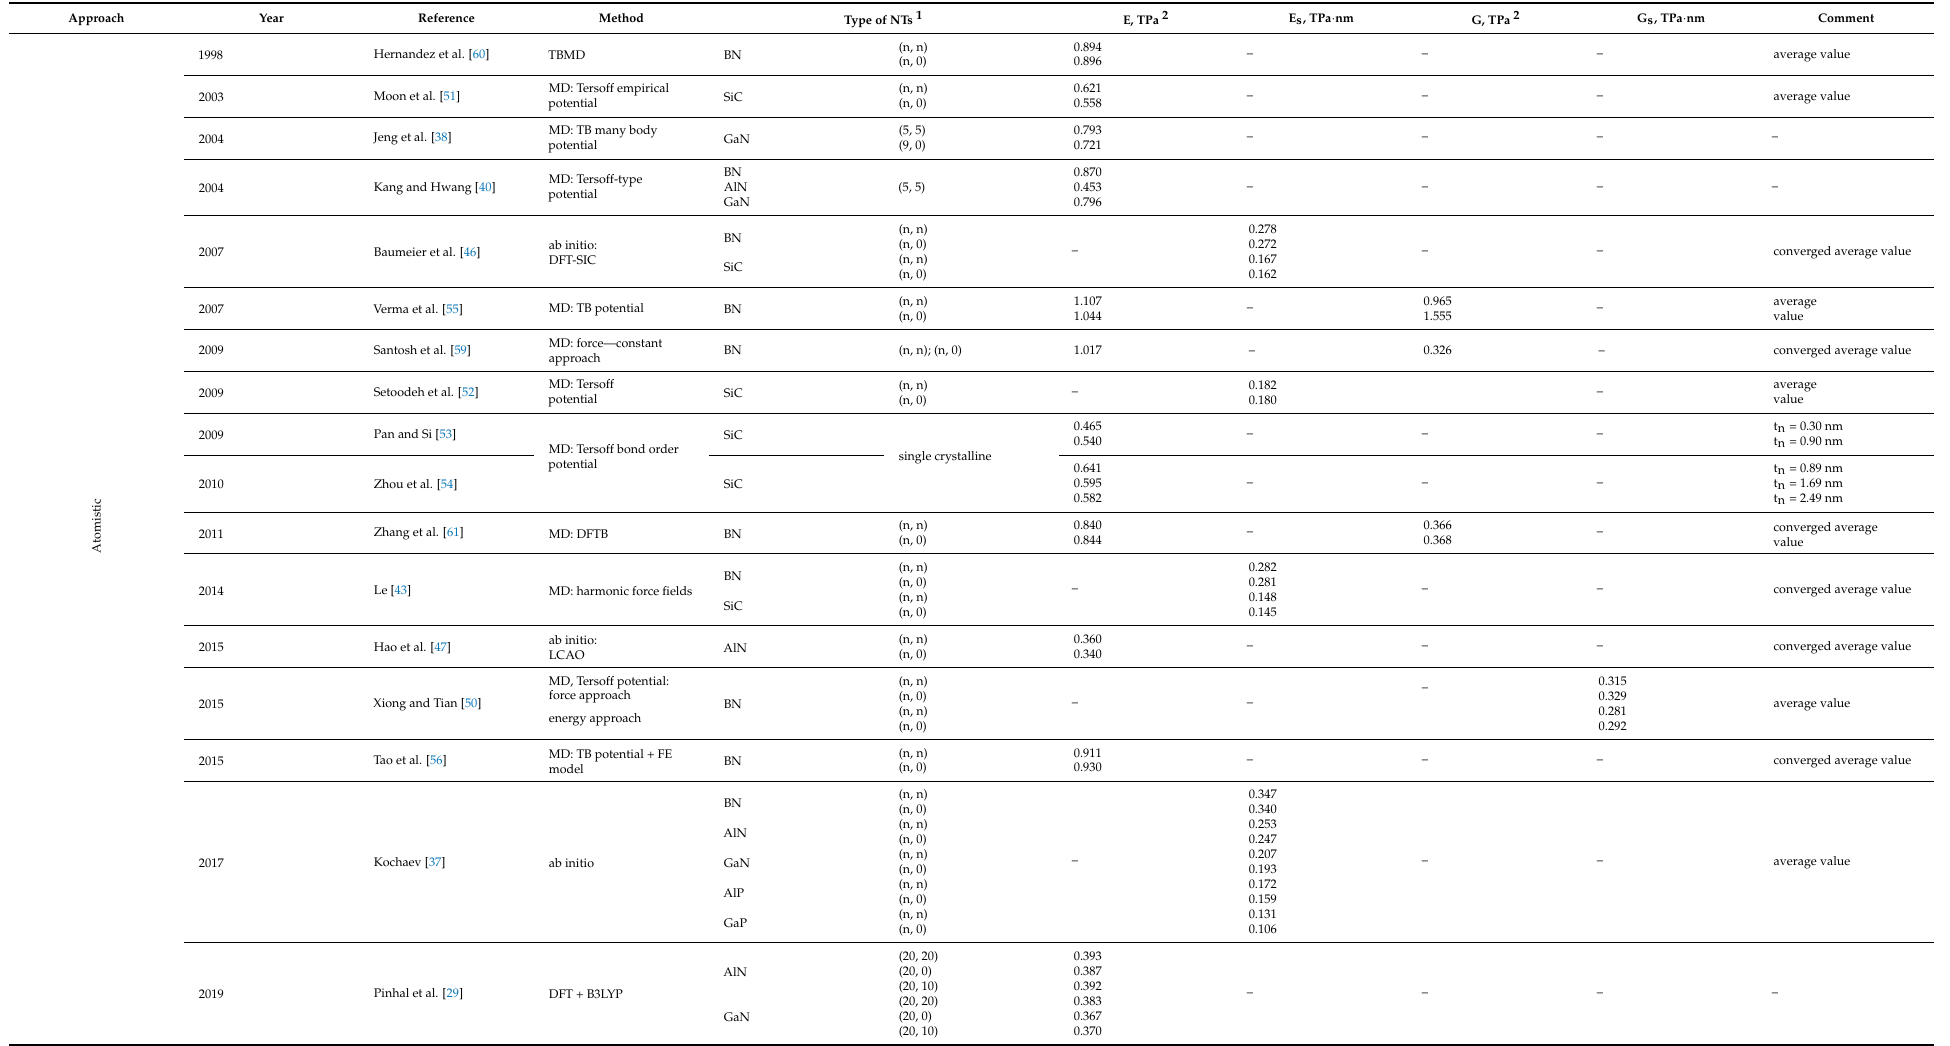
Table 2. Young’s and shear moduli results for non-carbon nanotubes reported in the